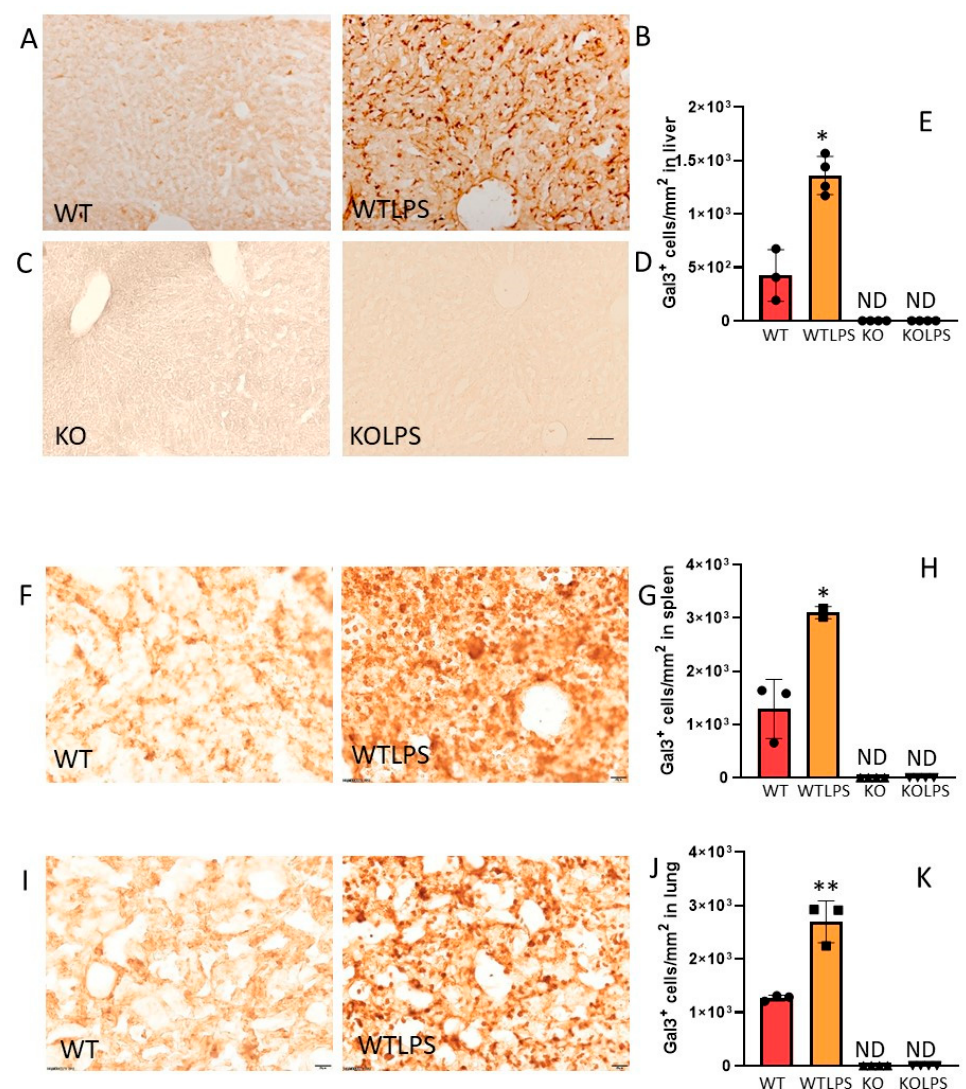
Figure 4. Gal3 expression in the liver, lung, and spleen of mice from the different treatments assayed. ( A ) Section from liver showing some Gal3 positive cells in a WT animal. ( B ) Immunoreactivity of Gal3 in a liver section from a WT animal injected i.p. with LPS. ( F ) Section from spleen showing some Gal3 positive cells in a WT animal. ( G ) Immunoreactivity of Gal3 in a spleen section from a WT animal injected i.p. with LPS. Again, a strong reaction can be seen. ( I ) Section from lung showing some Gal3 positive cells in a WT animal. ( G ) Immunoreactivity of Gal3 in a lung section from a WT animal injected i.p. with LPS, showing a strong reaction. As expected, in the case of Gal3KO animals, immunoreactivity of Gal3 was not found in any treatment assayed ( C , D ). Scale bar: ( A – D ), 100 μ m; ( F – J ), 20 μ m. Quantification of the density of Gal3 positive cells in liver ( E ), spleen ( H ),and lung ( K ) from the different treatments assayed. Results are mean ± SD of N = 3–4 animals, expressed as num- ber of cells per mm2. Statistical significance (two tailed Student- t test): * p < 0.01; ** p < 0.05. Abbre- viations: WT, wild type mice; WTLPS, wild type mice treated with LPS; KO, Gal3 knockout mice; KOLPS, Gal3 knockout mice treated with LPS.